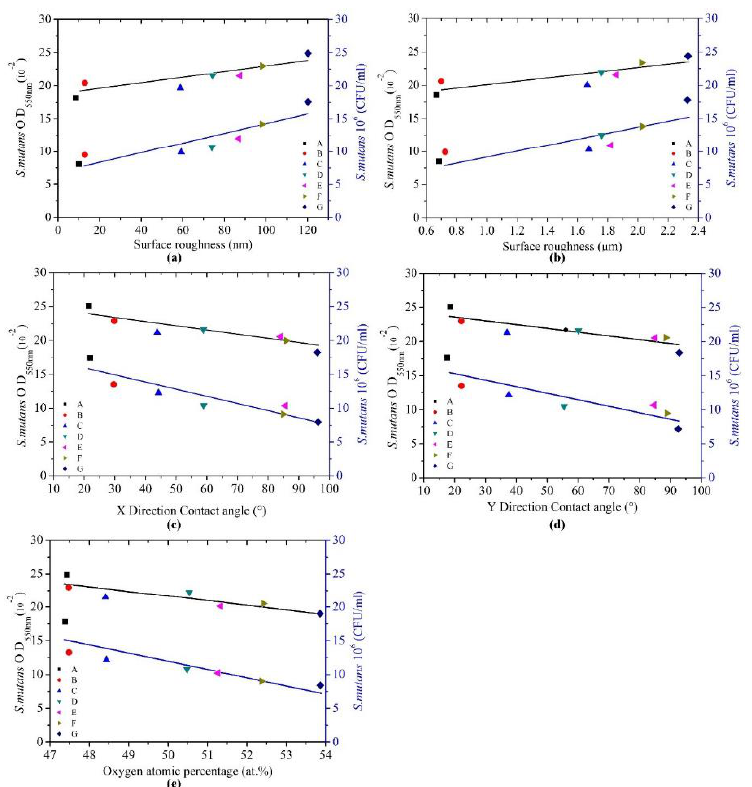
Figure 12. Relationship between the present of Specimen A–G surface characteristics and Streptococcus mutans bacterial counts (CFU/OD), It indicates that ( a ) micro/( b ) macro surface roughness and Streptococcus mutans bacterial counts are positive correlation, ( c ) X direction/( d ) Y direction contact angle and Streptococcus mutans bacterial counts are negative correlation, and ( e ) surface oxygen content and Streptococcus mutans bacterial, respectively, (Specimen A—electropolished for 300 s, Specimen B—electropolished for 200 s, Specimen C—electropolished for 100 s, Specimen D—chemically